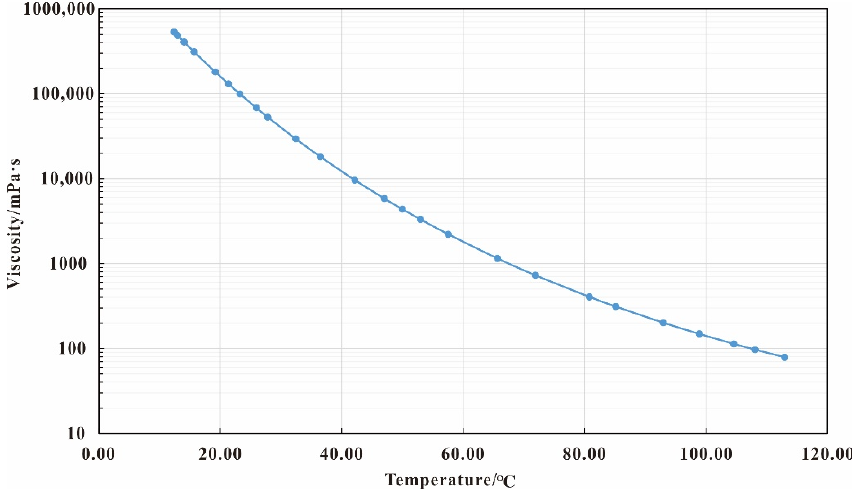
Figure 3. Viscosity–temperature relationship curve of crude oil from L block.